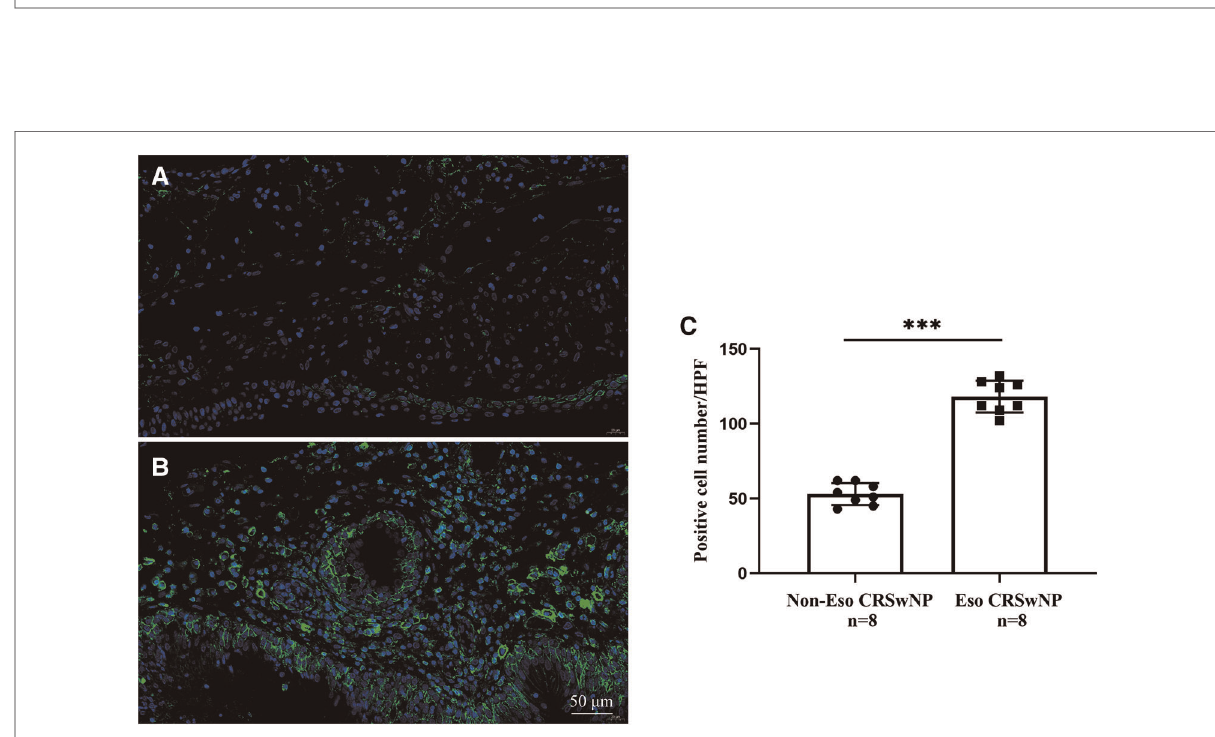
FIGURE 7 Representative immuno fl uorescence images of non-EOS CRSwNP ( A ) and EOS CRSwNP patients ( B ). ( C ) Quanti fi cation of S100A4 + cells in immuno fl uorescence staining both two groups. (magni fi cation, x 400) *** p <0.001, ns, no signi fi cance. Abbreviations: EOS CRSwNP, eosinophilic chronic rhinosinusitis with nasal